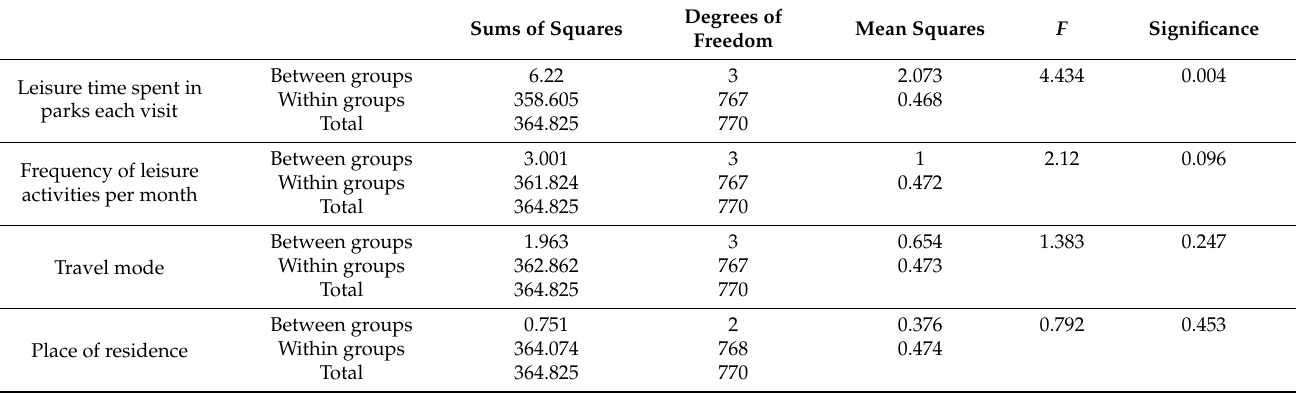
Table 9. Differences in the effects of individual leisure behavior characteristics on leisure